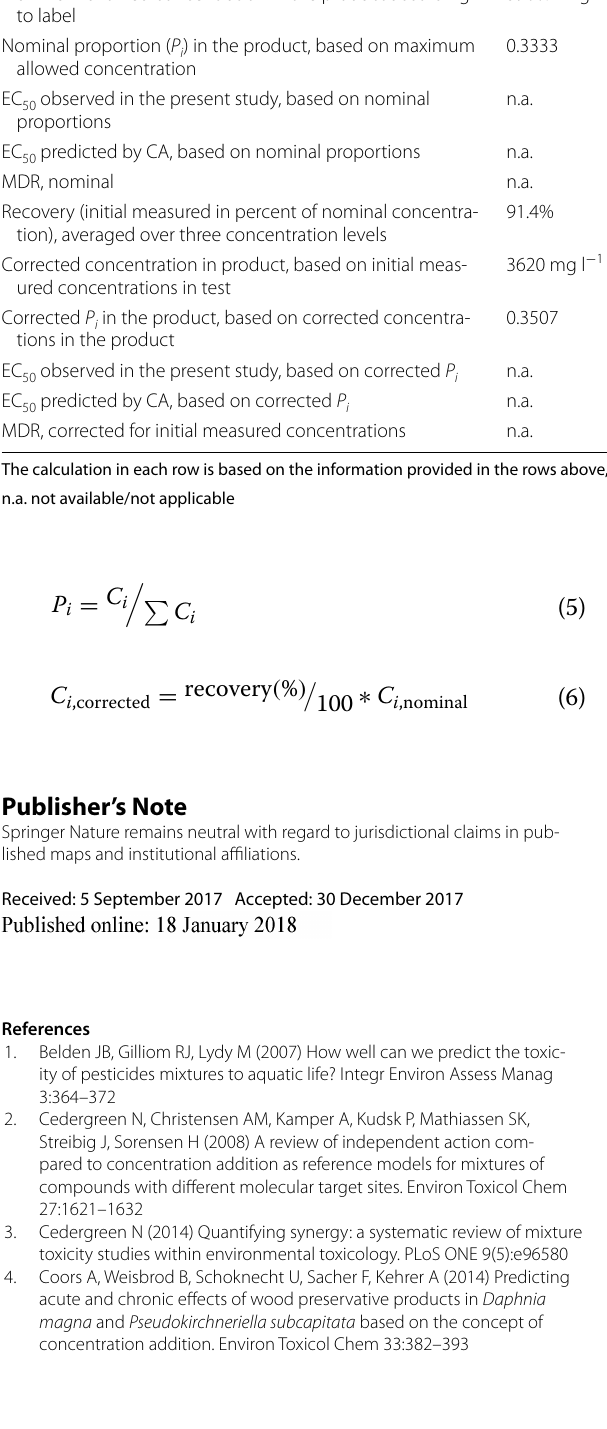
for a product considering only the a.s. at their maximum allowed concentra- 50